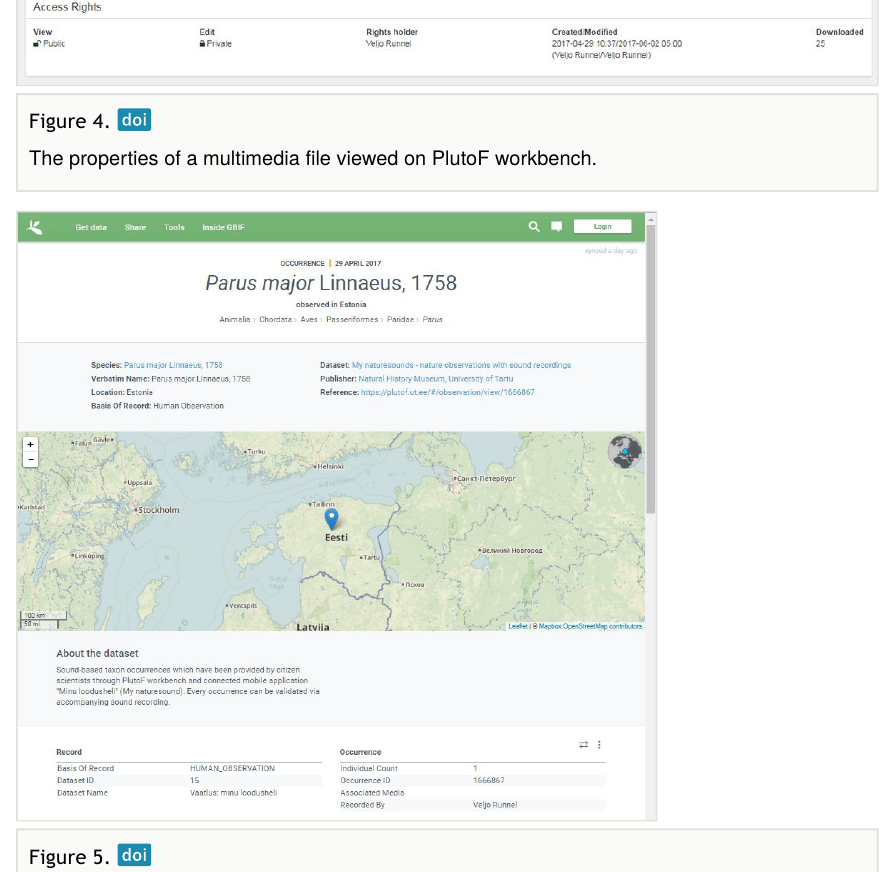
Figure 5. The details of an occurrence record viewed on GBIF